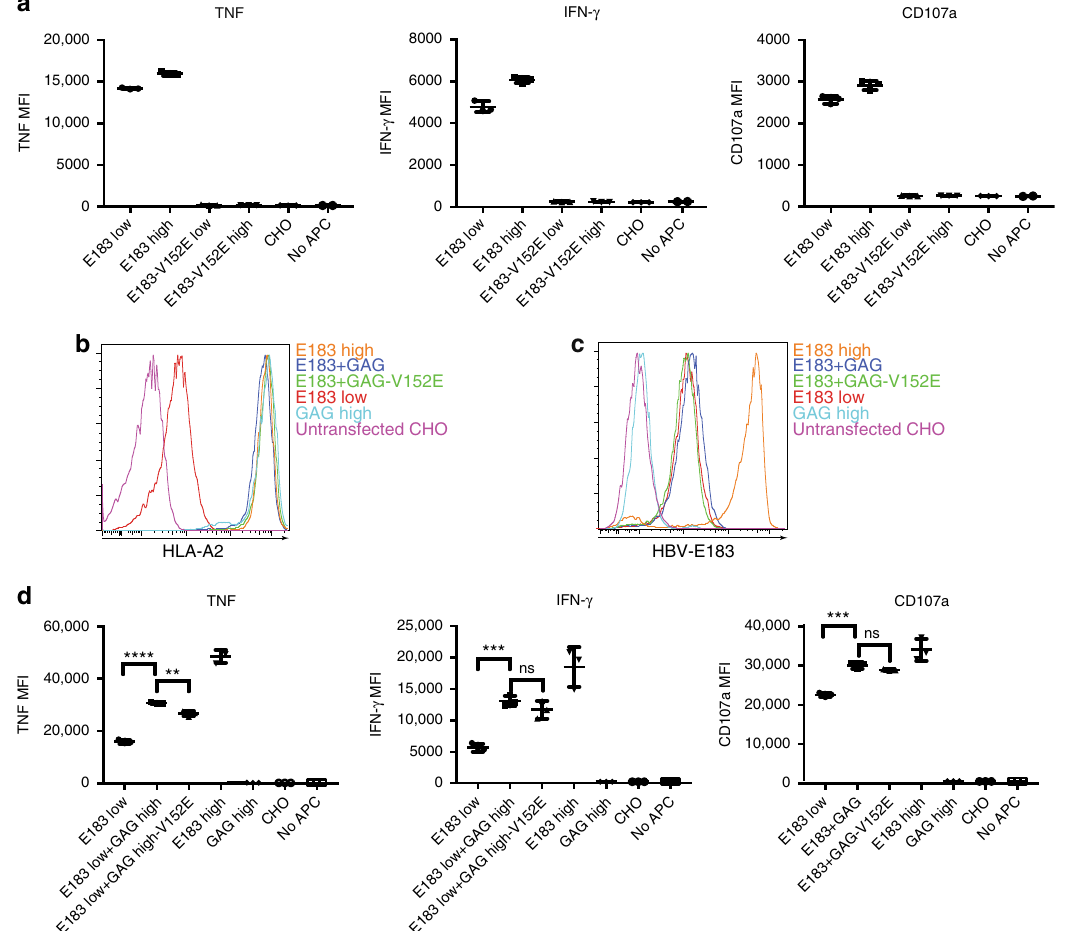
Fig. 4 TCR binding to nonstimulatory pMHCI is not required for coagonism in human T cells. a V152E mutation was introduced into the antigen sc E183- HLA-A2 which was then transfected into T-REx CHO cells and single cell clones were sorted. Indicated T-REx CHO clones panel was cocultured with human E183 CTL for 3 h. Cytokine production (TNF and IFN- γ ) and upregulation of the degranulation marker CD107a were assessed by antibody staining and fl ow cytometry. b V152E mutation was introduced into nonstimulatory sc GAG-HLA-A2 which was then transfected into the T-REx CHO clone that could simultaneously express low concentration of the antigen sc E183-HLA-A2. Anti-HLA-A2 ( b ) or anti-E183-HLA-A2 ( c ) staining was performed on the indicated T-REx CHO cells and analyzed by fl ow cytometry. d Human E183 CTL were cocultured with the indicated T-REx CHO clones panel for 3 h. Cytokine production (TNF and IFN- γ ) and upregulation of the degranulation marker CD107a were assessed by antibody staining and fl ow cytometry. Statistical signi fi cance was determined by using unpaired two-sided Student ’ s t test and shown as mean ± s.d. (ns nonsigni fi cant, * p < 0.05, ** p < 0.01, *** p < 0.001, **** p < 0.0001). Data are representative of three independent experiments. MFI mean fl uorescence